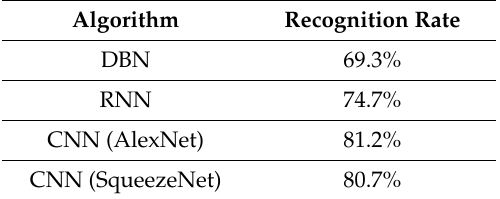
Table 3. Comparison of di ff erent algorithms for chronic